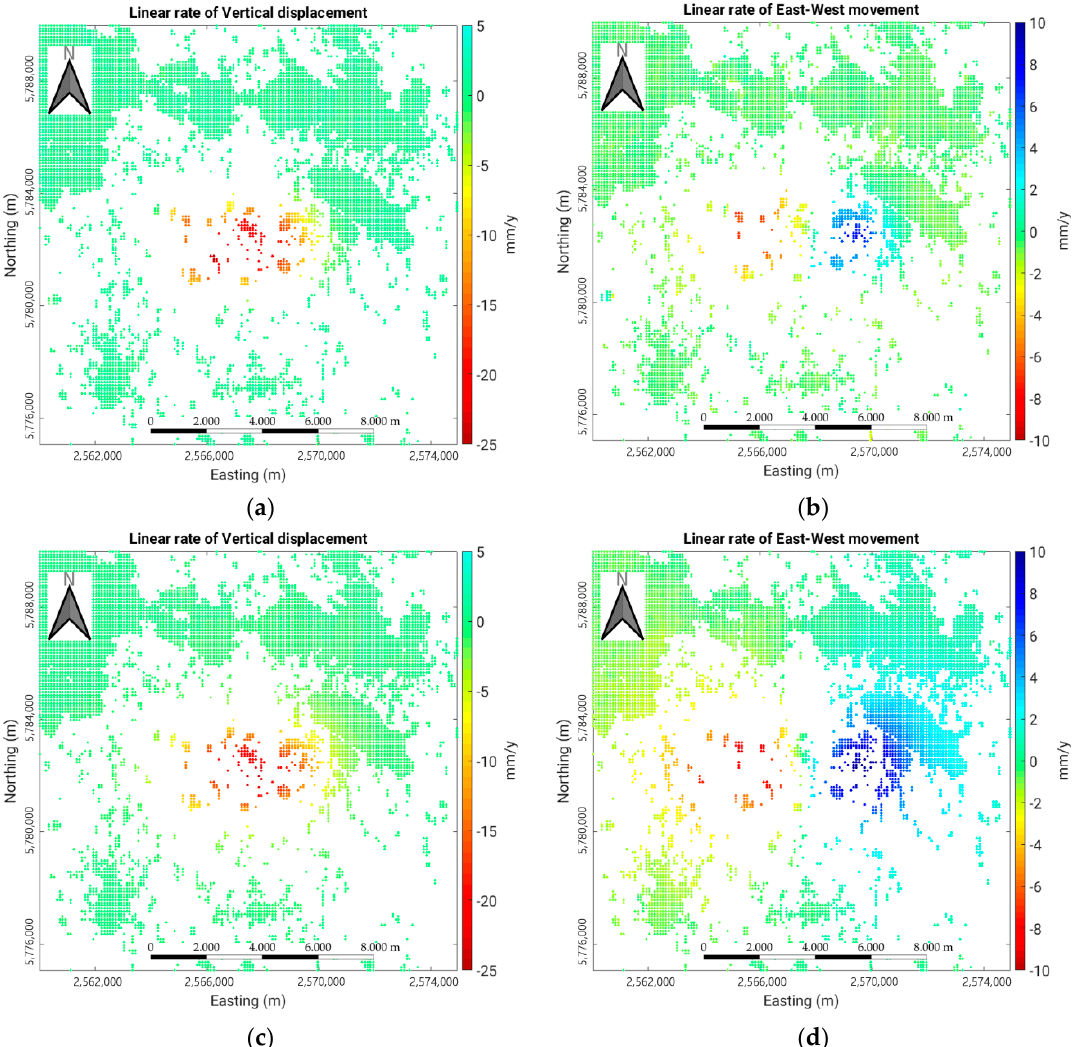
Figure 13. Linear displacement rates transformed to vertical and east-west direction. First row from geometric orbit combination, second row with Multi-Mogi approach.